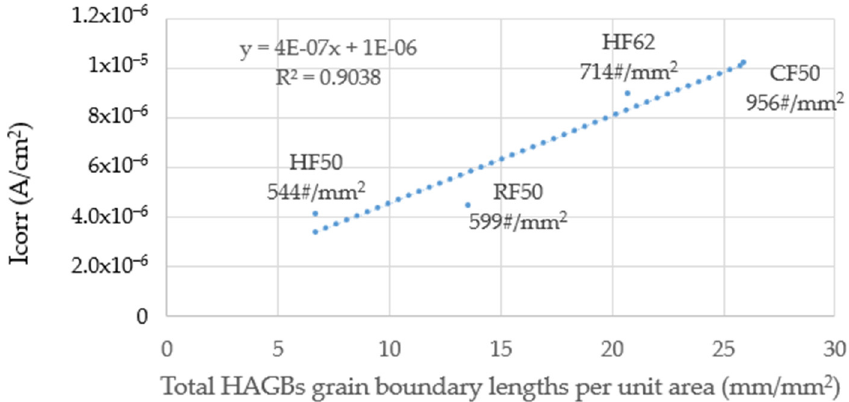
Figure 11. Relationship between I corr and total HAGBs grain boundary lengths per unit area (mm/mm 2 ) for different samples; total particle counts (particle size >0.2 µ m) are included. Table 6. Measured 2nd Phase Particle Size Distribution for Samples from Optical Micrographs; Par- ticles Counted from 1 μ m to Maximum Size in Each Sample (CF50, RF50, HF50, and HF62).